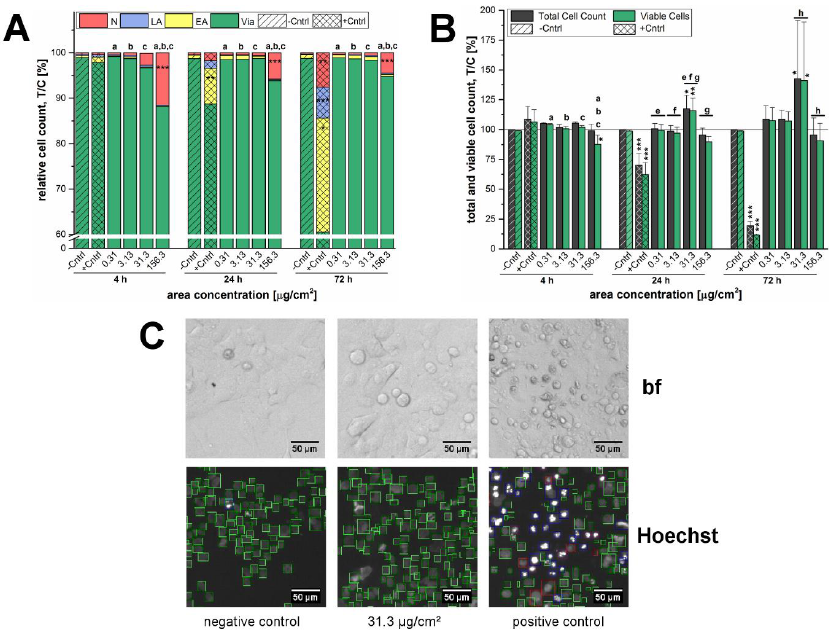
Figure 2. Influence of 12 nm SiO 2 NPs on cell proliferation and cell death of GXF251L cells monitored microscopically after an incubation period of 4 h, 24 h and 72 h. Staurosporine (800 nM) was applied as a positive control (+Cntrl) resulting in apoptotic and necrotic cell death. ( A ) Viable (Via), early apoptotic (EA) and late apoptotic (LA), as well as, necrotic cells (N) are plotted in relation to the total cell count; ( B ) The depicted bars represent the total cell counts and the respective amount of viable cells. Total cell count was quantified in relation to the negative control ( − Cntrl). Cell viability was quantified in relation to the viability of the negative control, as well as, the total cell count of the negative control (T/C [%]). The solid line represents the negative control set to 100%; ( C ) Represented are microscopic bright field (bf) images of the negative and positive control and the incubation sample with 31.3 µ g/cm 2 of 12 nm SiO 2 NPs after an incubation time of 24 h. Furthermore, the software analysis after detection in the Hoechst-channel is shown distinguishing between viable cells (green), early (blue) and late (violet) apoptotic cells, as well as, necrotic cells (red). Scale bars are equivalent to 50 µ m. Statistical analysis was performed by One-way ANOVA followed by Fisher’s LSD test. Significances indicated as * refer to a comparison to the respective negative control (* ≡ p ≤ 0.05; ** ≡ p ≤ 0.01 and *** ≡ p ≤ 0.001; n ≥ 3). The same letters indicate a significant difference of these data (in (A): refers to necrotic cells only) with a statistical level of at least p ≤